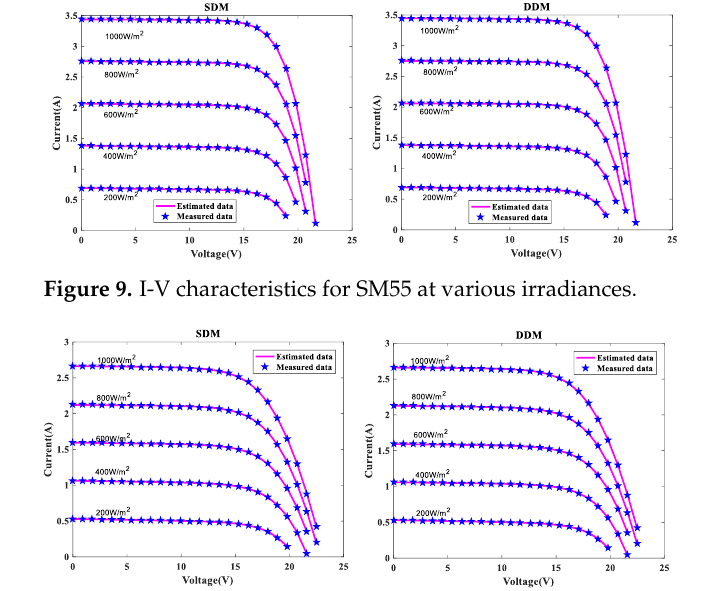
Figure 10. I-V characteristics for ST40 various